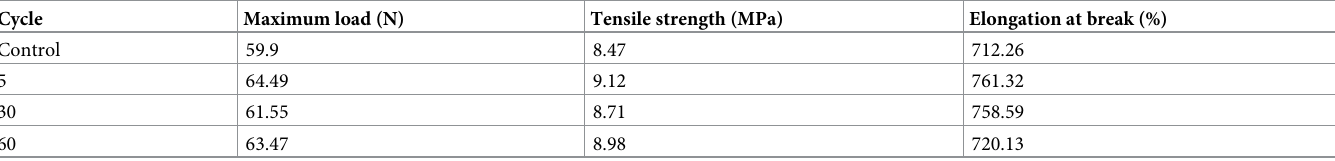
Table 6. Tensile strength of the strap after UV-C irradiation at a dose of 430 μ Watt-sec/cm 2 for 1 minute.